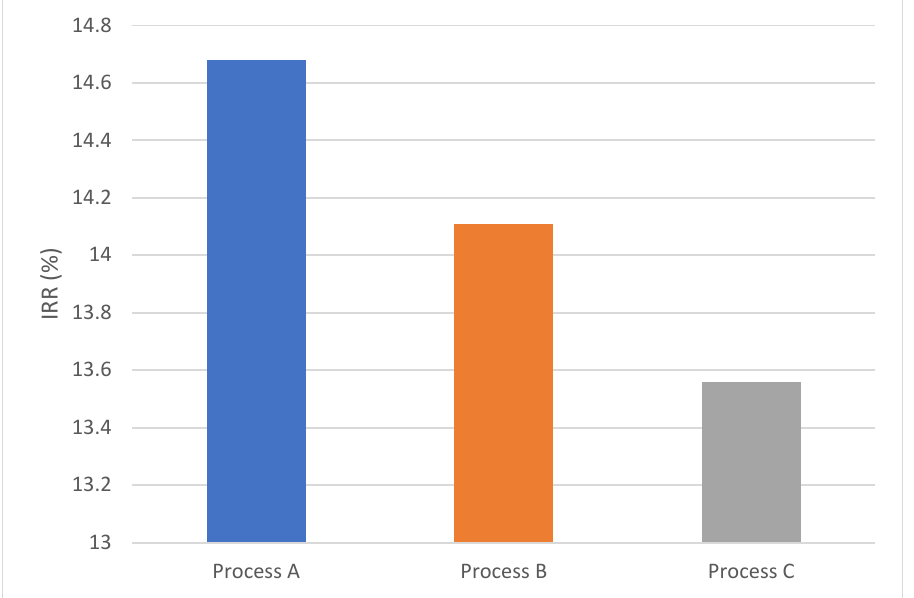
Figure 11. NPV of designed system.